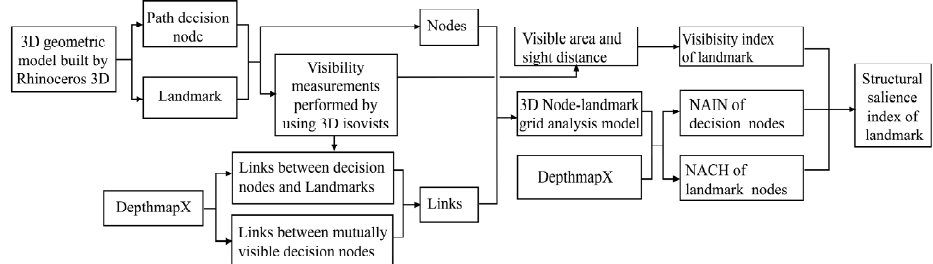
Figure 1. Research